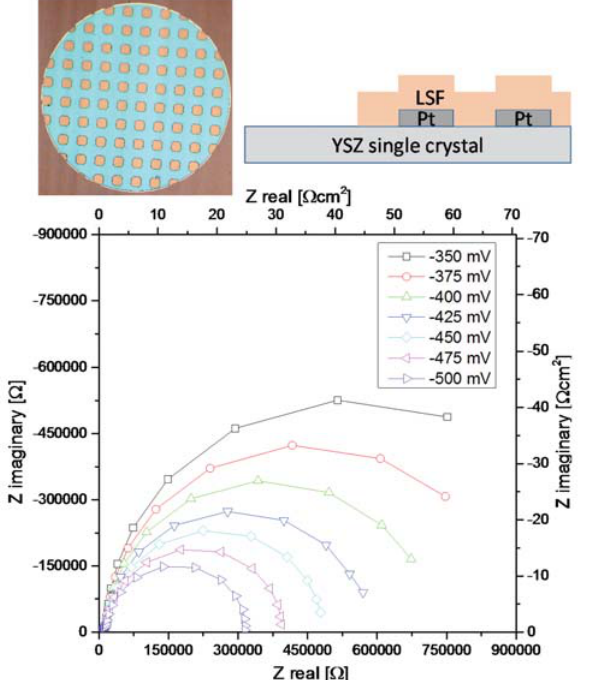
Fig. 4. Impedance spectra measured in air at 600 °C on circular LSF thin film microelectrodes with Pt grid beneath (the photograph of a microelectrode and a sketch of the cross section is also shown); the microelectrodes were deposited on top of an yttria stabilized zirconia single crystal (porous LSF/Pt counter electrode). Depen- ding on the applied cathodic bias voltage the impedance changes.